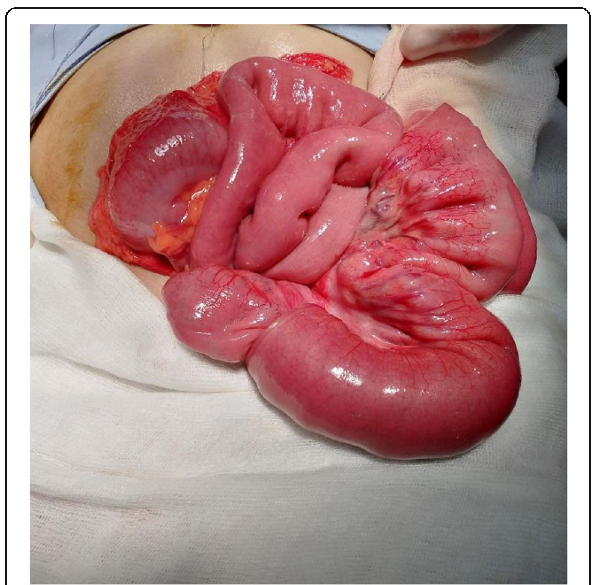
Fig. 3 Pre-operative view of compounded ileo-ileal intussusception